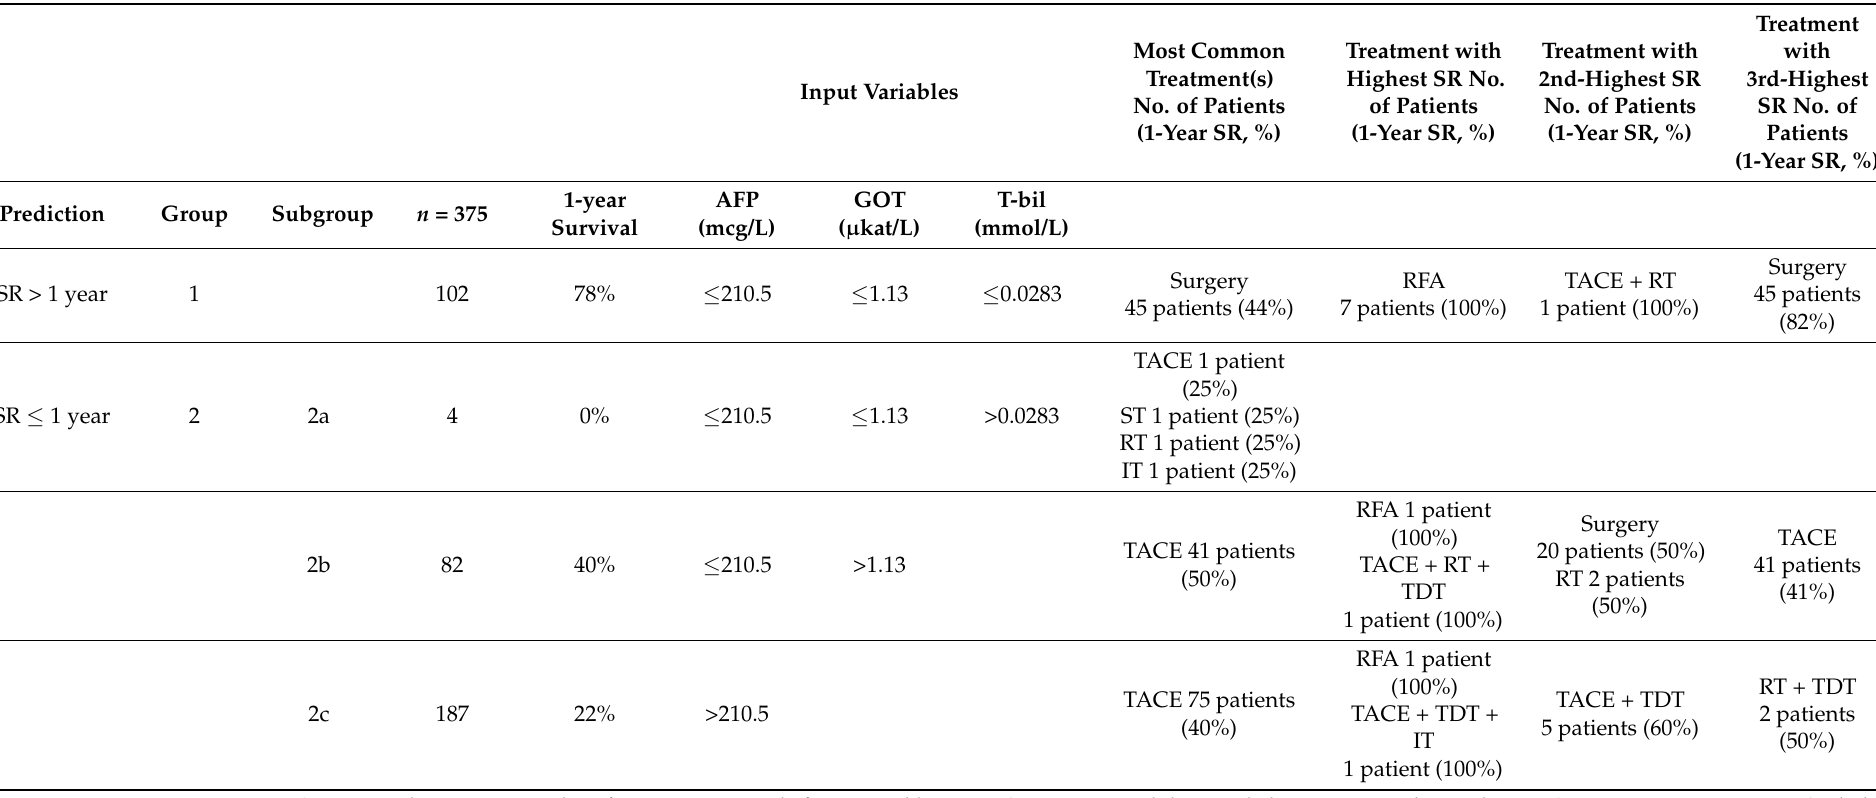
Table 5. Clinical Use of Post-pruning